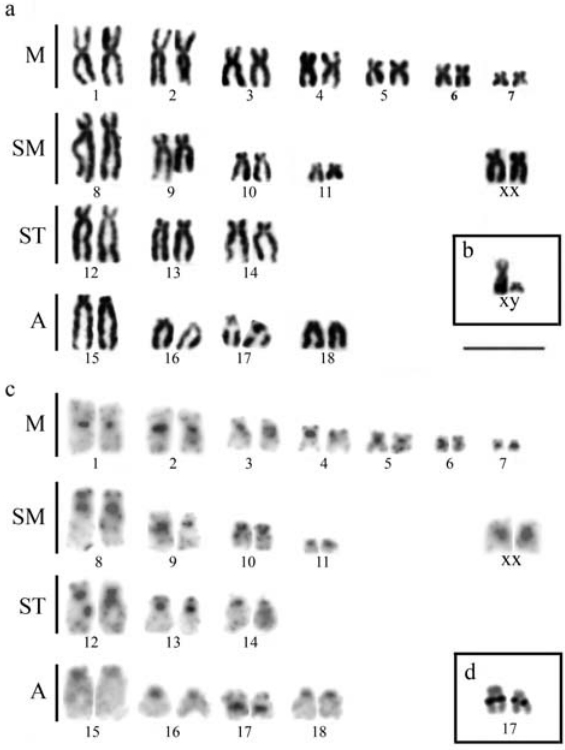
Figure 2 - Karyotype of Pteronura brasiliensis : (a) female and (b) sex chromosomes of male standard staining; (c) C-banding and (d) Nucleolar pair stained with silver nitrate (Bar = 10 μ